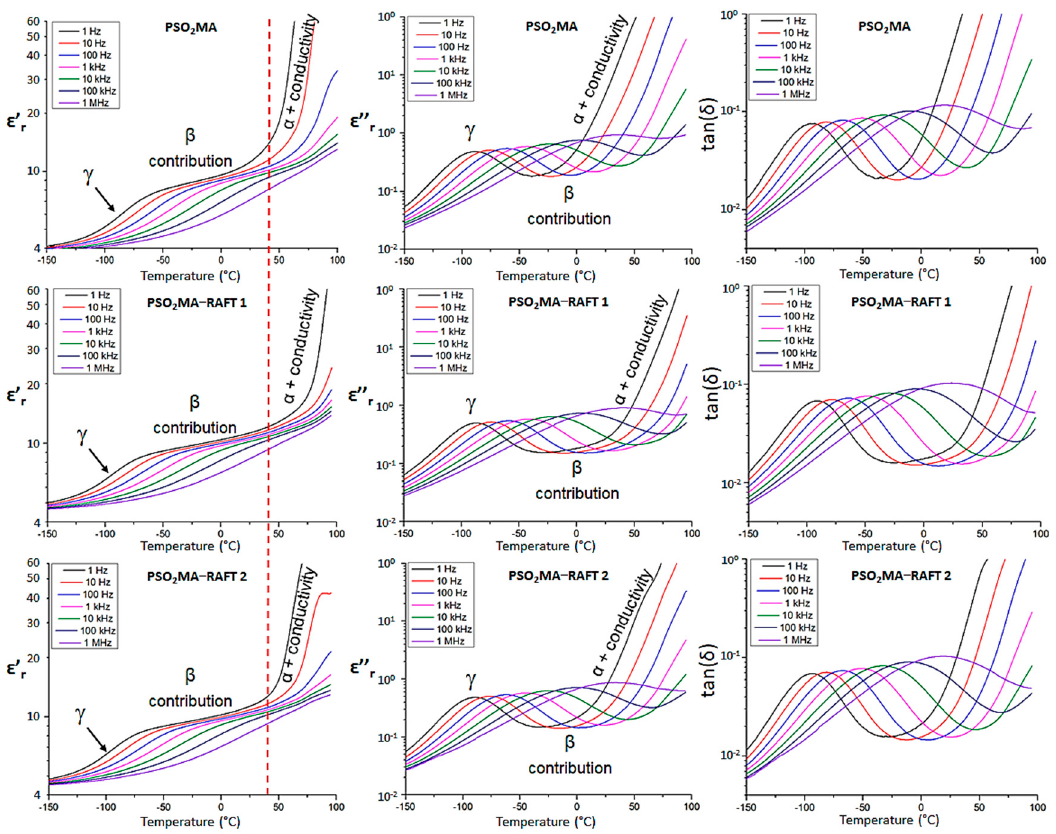
Figure 6. Evolution of ε ’ r , ε ” r and tan( δ ) with the temperature at different frequencies for PSO 2 MA, PSO 2 MA − RAFT1, and PSO 2 MA − RAFT2.